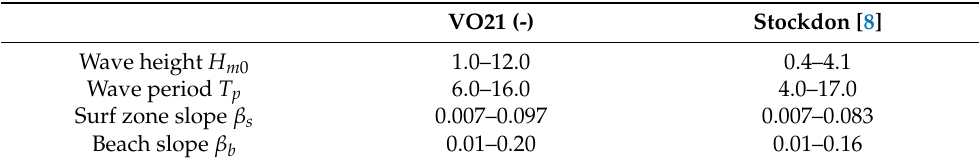
Table 2. Range of hydrodynamic and topographic conditions in the VO21 dataset and the Stockdon field data